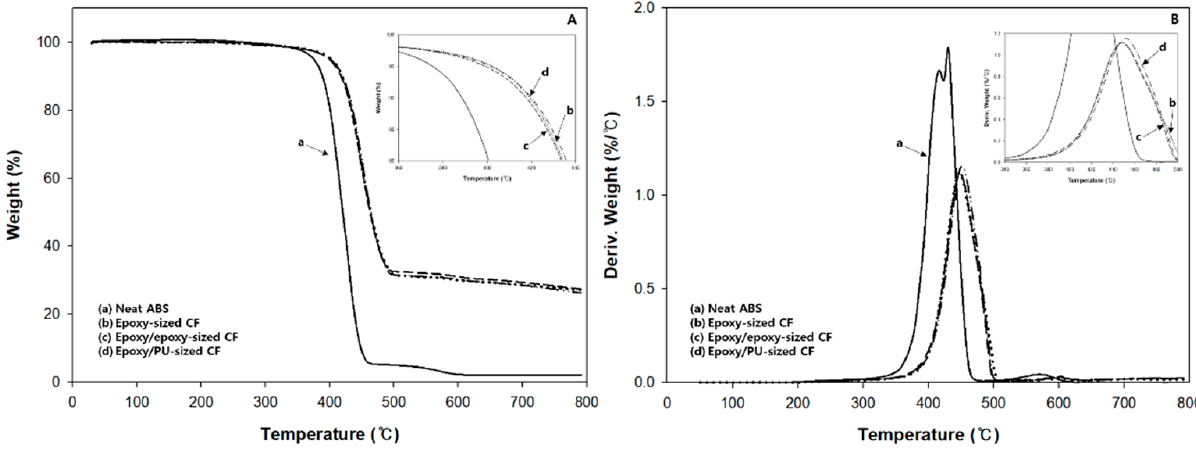
Figure 5. ( A ) TGA and ( B ) DTG curves measured for neat ABS and carbon fiber/ABS composites with (epoxy) single-sized and (epoxy + epoxy, epoxy + PU) dual-sized carbon fibers.